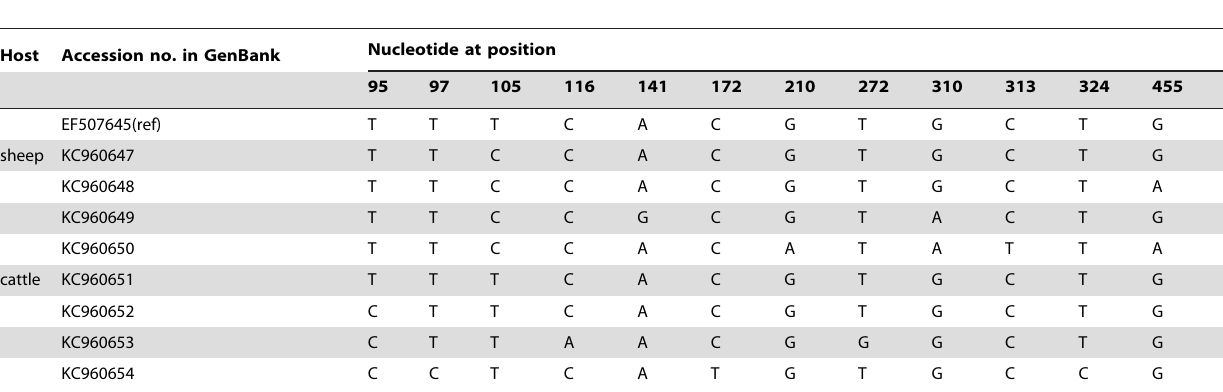
Table 2. Variations at the gdh locus among intra-assemblage E of G. duodenalis isolates from sheep and cattle in Heilongjiang Province,